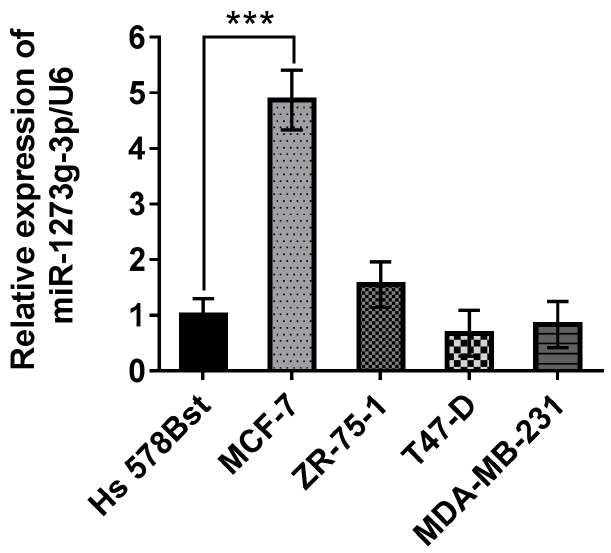
Figure 4. Relative Expression of miR-1273g-3p in breast cancer cell lines.*** p